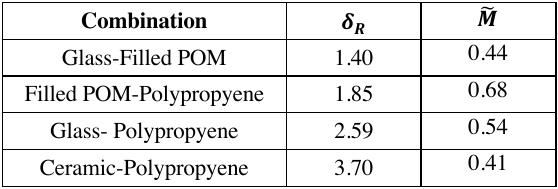
Table 1 . Bi-dispersed mixtures employed.